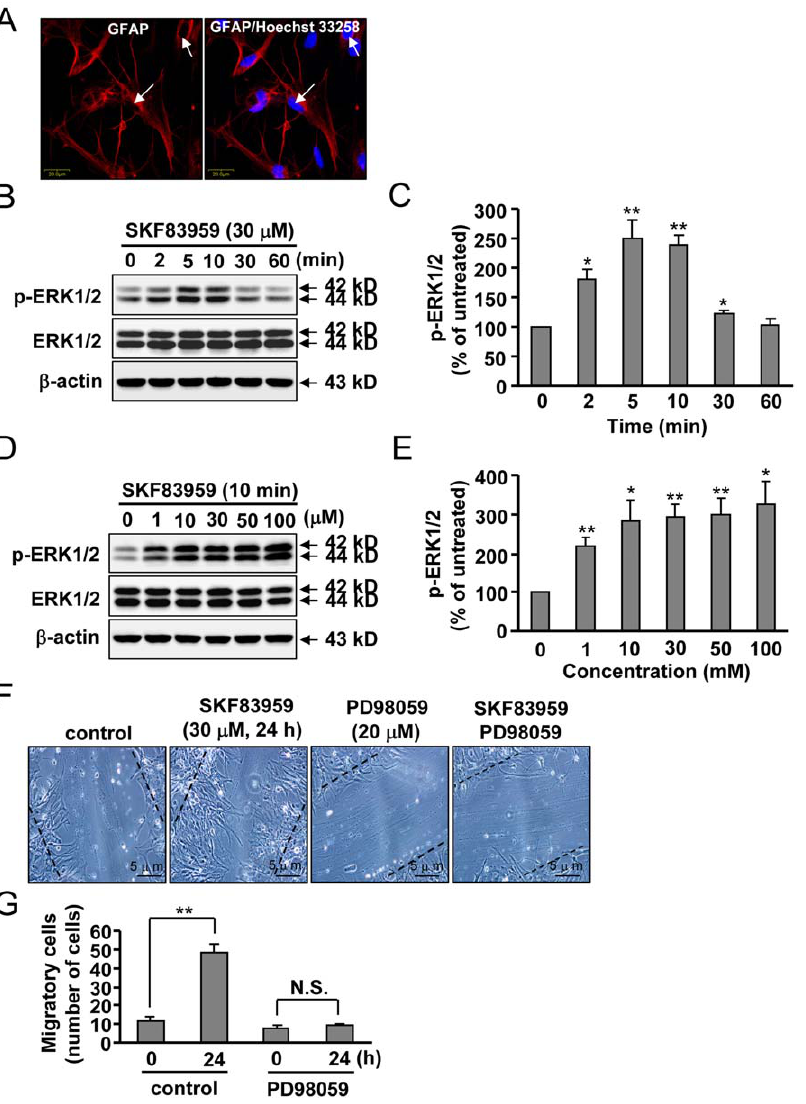
Figure 1. Effects of SKF83959 on ERK1/2 phosphorylation and cell migration in cultured rat astrocytes. (A) Cultured cortical astrocytes were identified using GFAP immunofluorescence and Hoechst 33258 staining. Bar: 20 m m. (B) Cultured astrocytes were incubated with 30 m M SKF83959 for 2 to 60 min. (C) A time-course analysis of ERK1/2 phosphorylation levels upon SKF83959 incubation from three independent experiments (Mean 6 S.E., n=3, ** P , 0.01 or * P , 0.05, vs. control). (D) Cultured cortical astrocytes were treated with SKF83959 at different concentrations (1, 10, 30, 50, and 100 m M) for 10 min. (E) Quantification of ERK1/2 phosphorylation level in astrocytes upon incubation with different concentrations of SKF83959 in three independent experiments (Mean 6 S.E., n=3, ** P , 0.01 or * P , 0.05, vs. control). (F) Effects of PD98059 (20 m M, 30 min), a specific inhibitor of MAP kinase, in SKF83959 (30 m M, 24 h)-induced migration of astrocytes. Bar: 5 m m. (G) Quantification of SKF83959- induced migration of astrocytes upon pretreatment with PD98059 (Mean 6 S.E., n=3, ** P , 0.01, 24 h vs. 0 h). N.S.: no